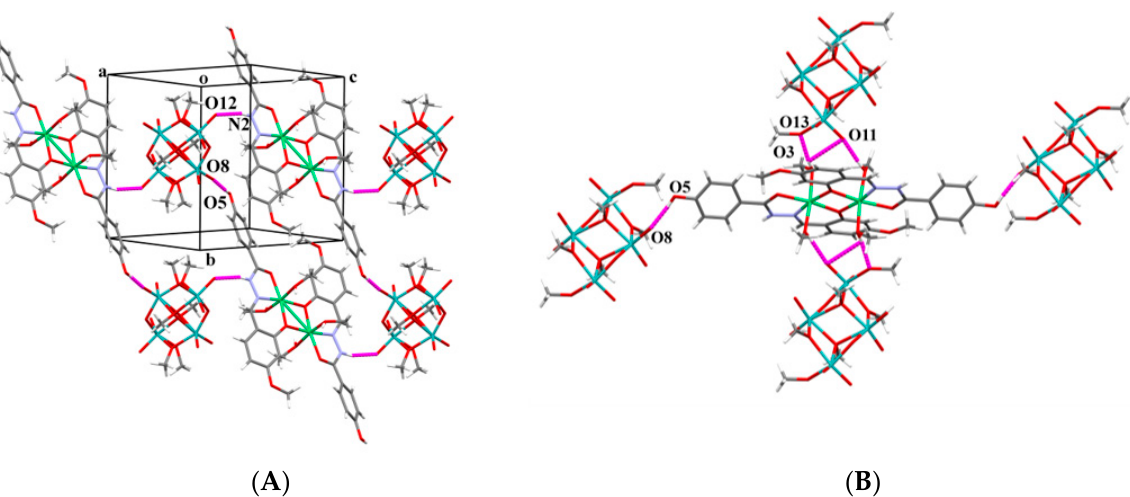
Figure 8. ( a ) Supramolecular linkage of cations and anions into 1D zig-zag chain parallel to c axis via N2-H2N ∙∙∙ O12 and via O5-H5O ∙∙∙ O8 intermolecular hydrogen bond along a axis into 1D chains; ( b ) trapped [Ni 2 (HL 4OMe ) 2 (CH 3 OH) 4 ] 2+ cation by four [Mo 4 O 10 (OCH 3 ) 6 ] 2 − anions.